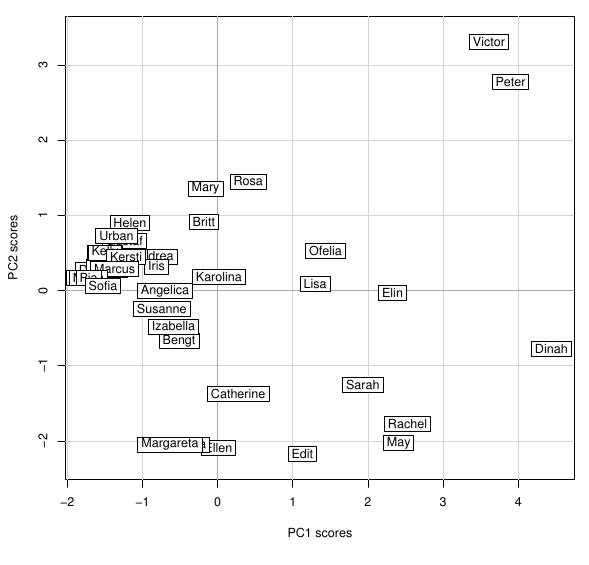
Figure 3 User profiles of the study participants . These are repre- sented as their scores along the first two principal compo- nents, labelled by their fictitious